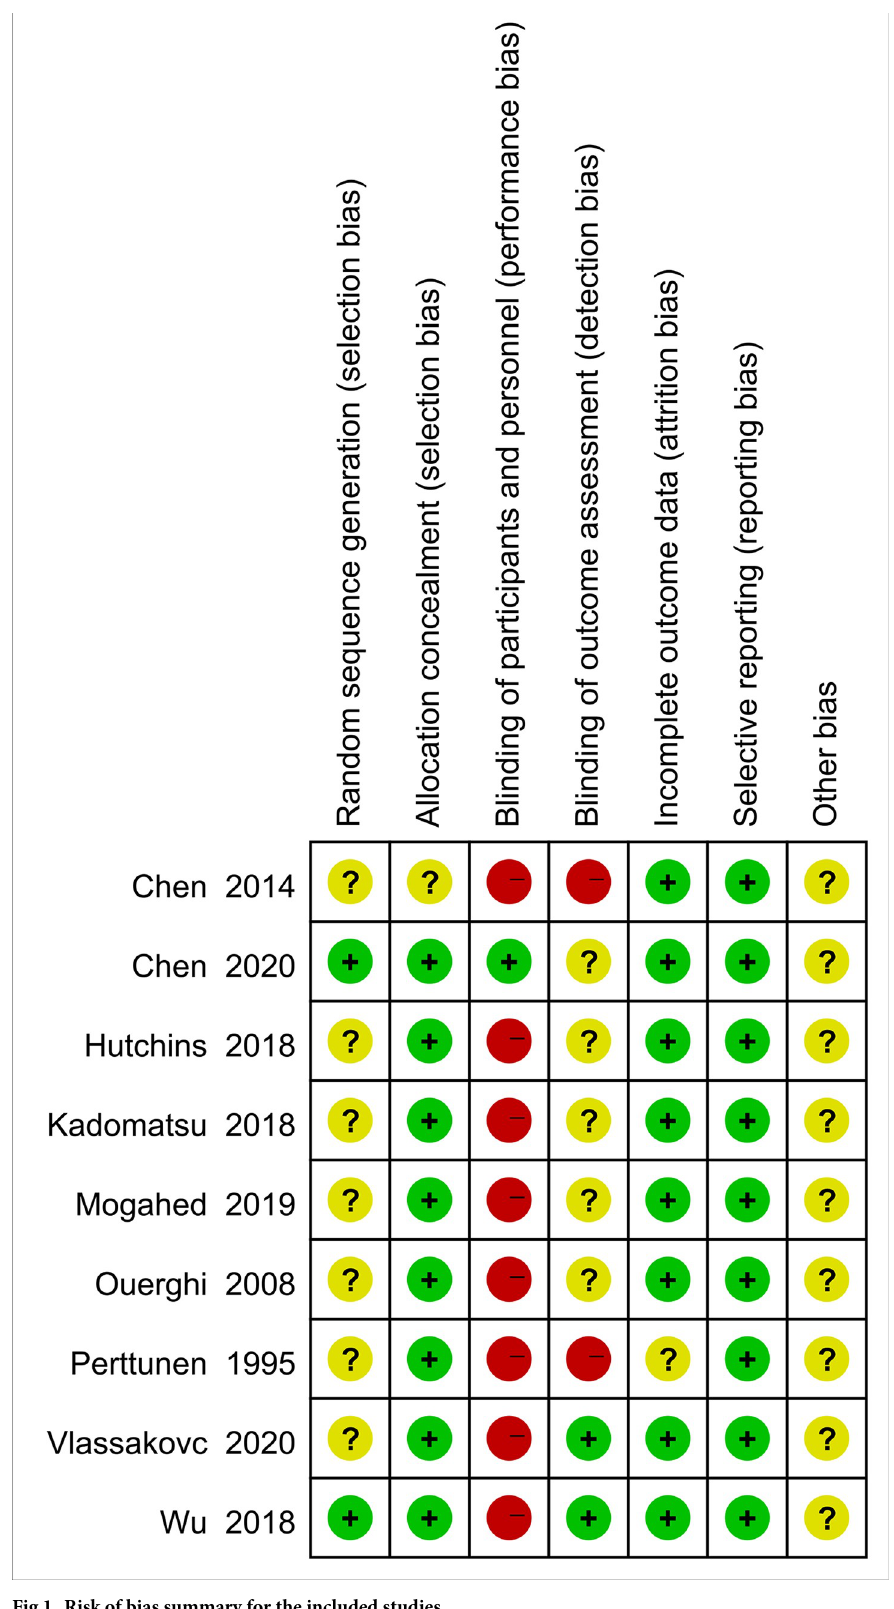
Fig 1. Risk of bias summary for the included studies.